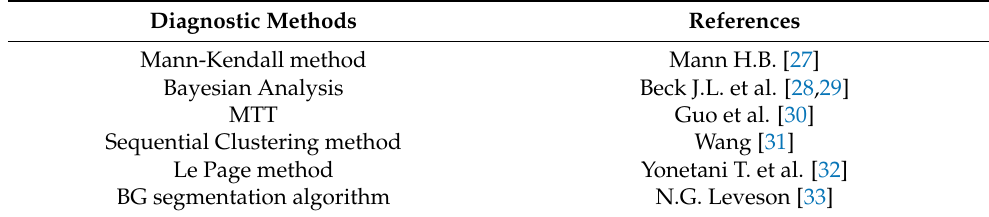
Table 2. Diagnostic methods and sources of